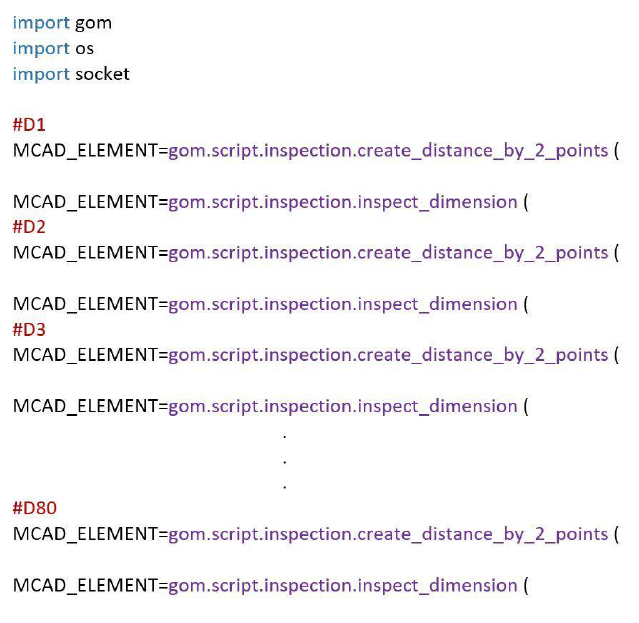
Figure 11. Script with recorded allowances.